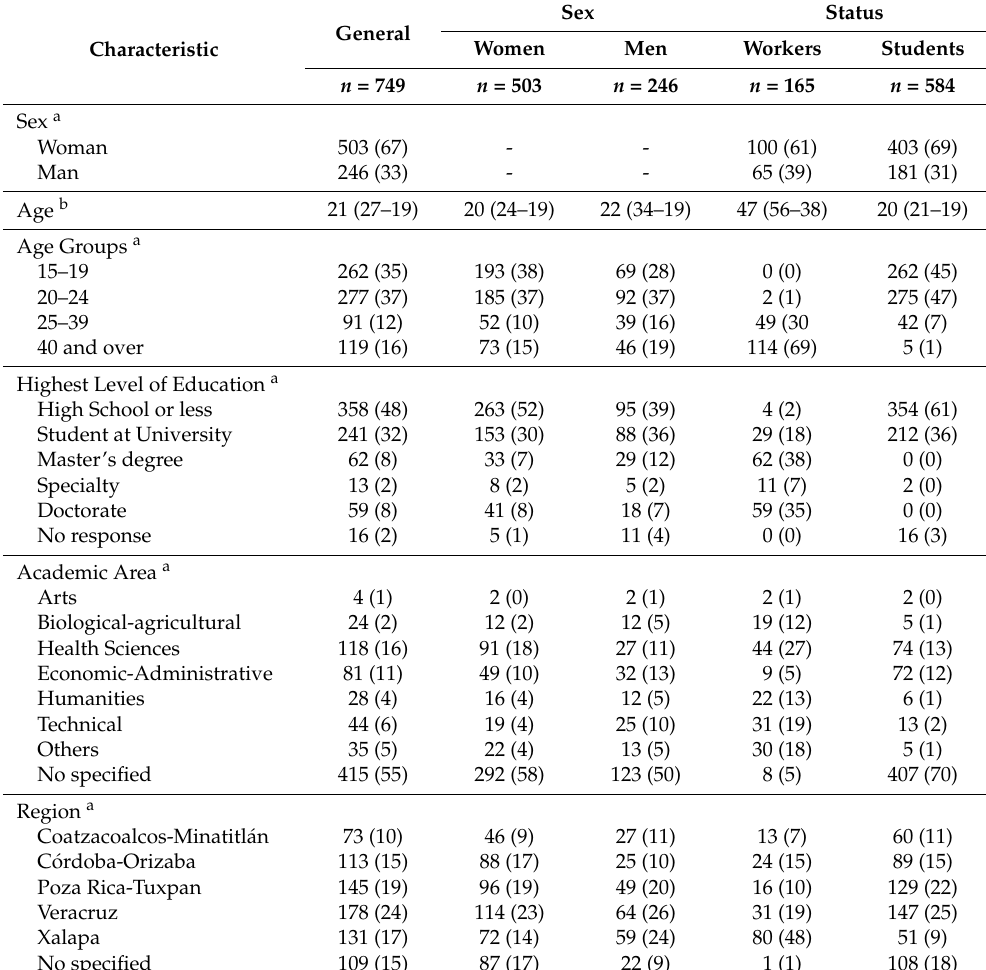
Table 1. Demographic characteristics of the